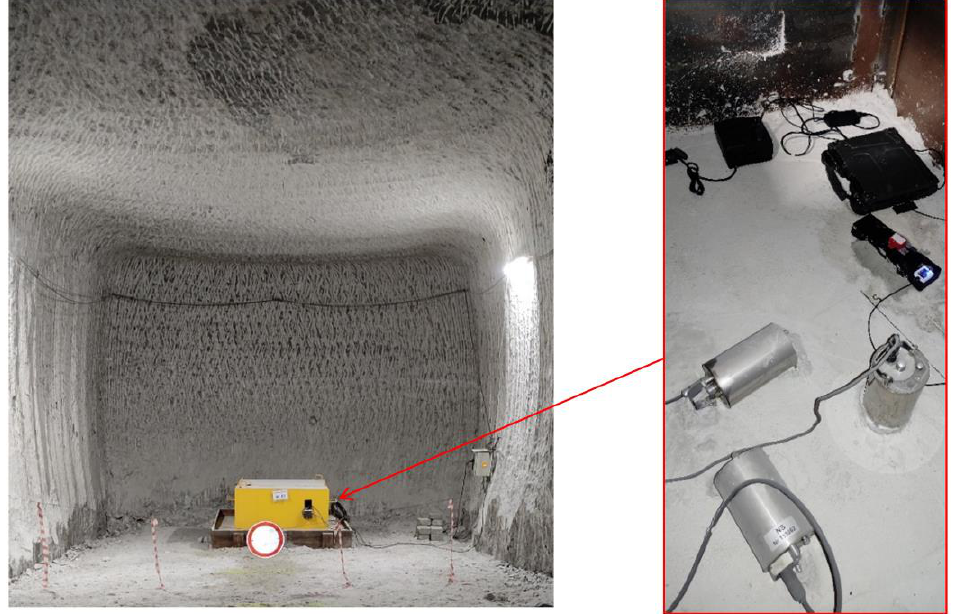
Figure 2. View of the trial site for validation tests in the salt chamber.